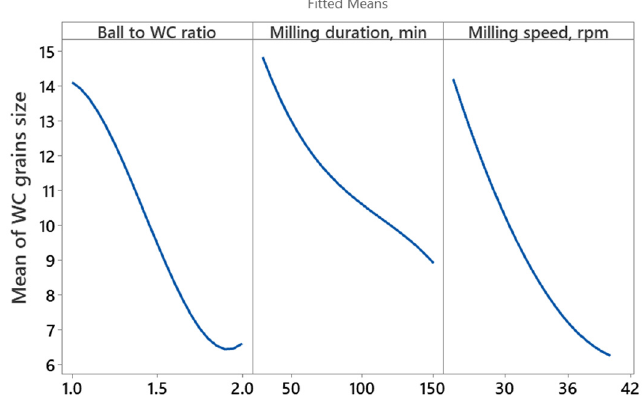
Figure 6. Main effect plots for the grain sizes of carbidized WC after ball milling.